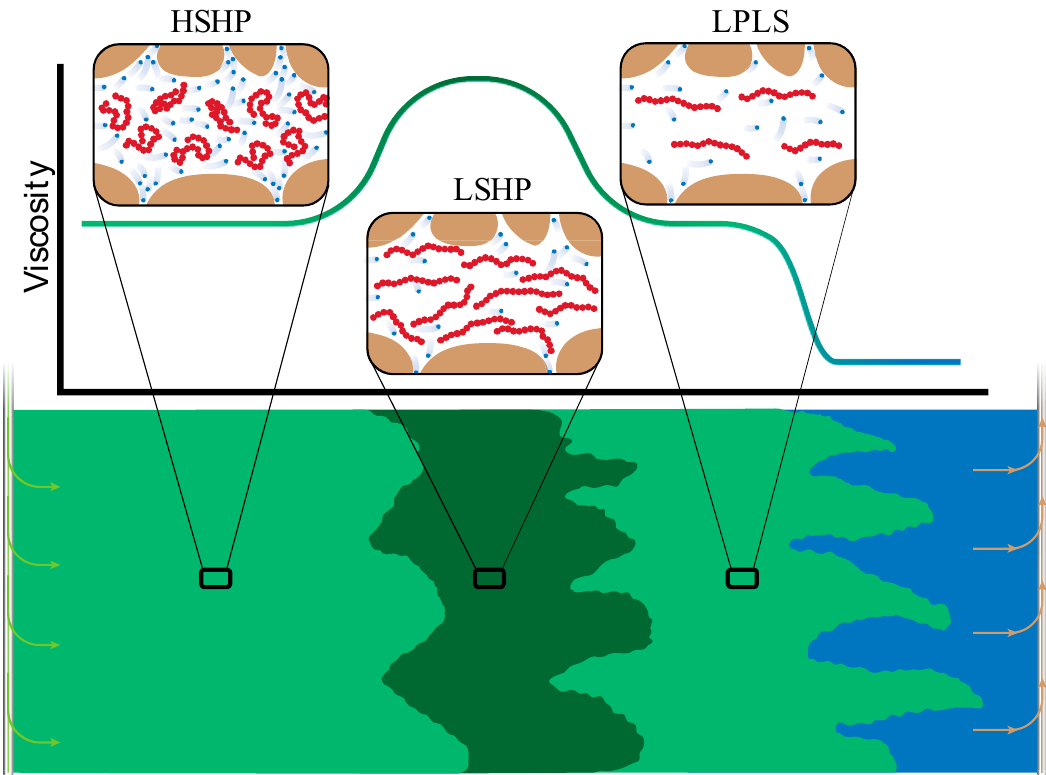
Figure 1. Illustration showing how the compositionally-tuned slug-based polymer flooding scheme works: Owing to polymer acceleration, a transition zone forms between the leading and trailing slugs, where polymer solution viscosity is significantly higher than the injected viscosities. The zones on the left, middle, and right correspond, respectively to high-salinity-high-polymer (HSHP) concentration (trailing slug), low salinity-high polymer (LSHP) concentration (mixing zone), low-salinity-low-polymer (LSLP) concentration (leading slug).